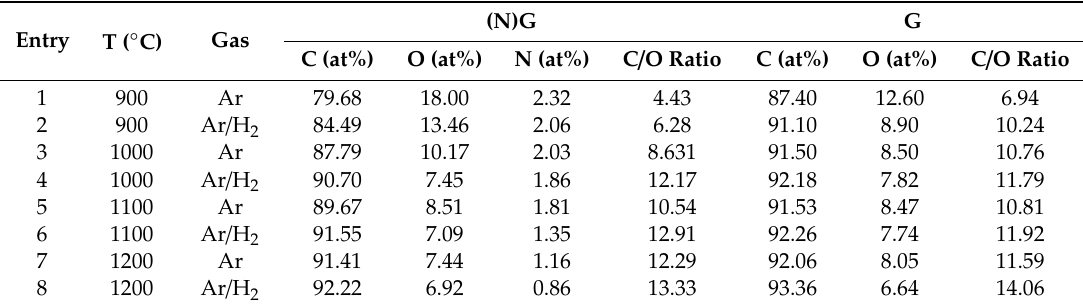
Table 2. Elemental composition of graphene films prepared from chitosan or alginic acid according to the XPS data 1 .